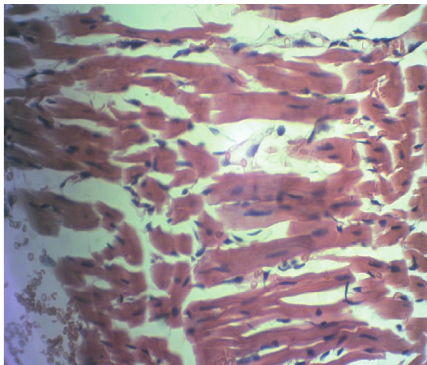
Figure 3: A cross-sectional representative of the normal rat heart showing normal cardiac architecture ( × 400 magnification, hema- toxylin-eosin stain).